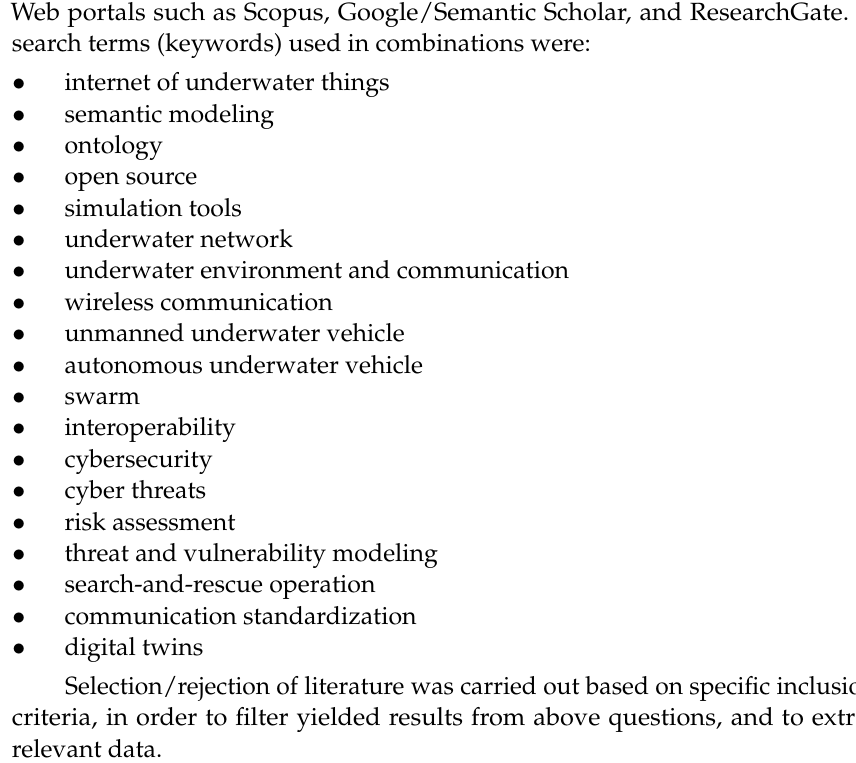
Figure 6. PRISMA flowchart of second primary question.